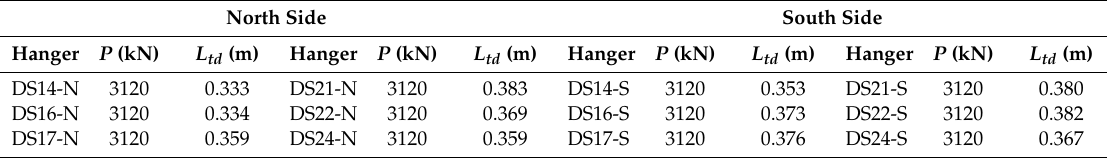
Table 8. Target values of the control parameters of tensioning round 4.